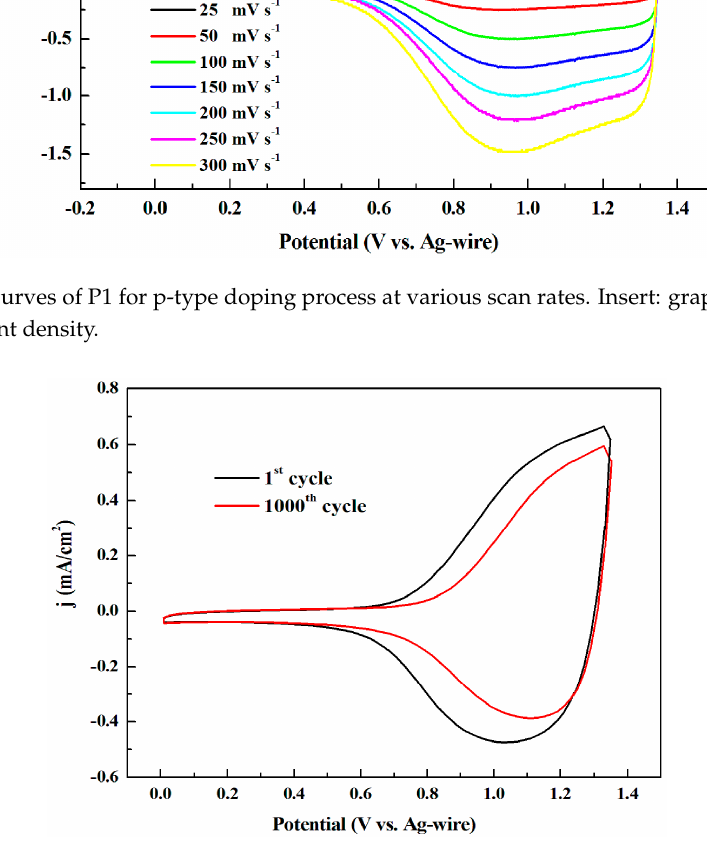
Figure 4. The first and the 1000th CV curve of P1.